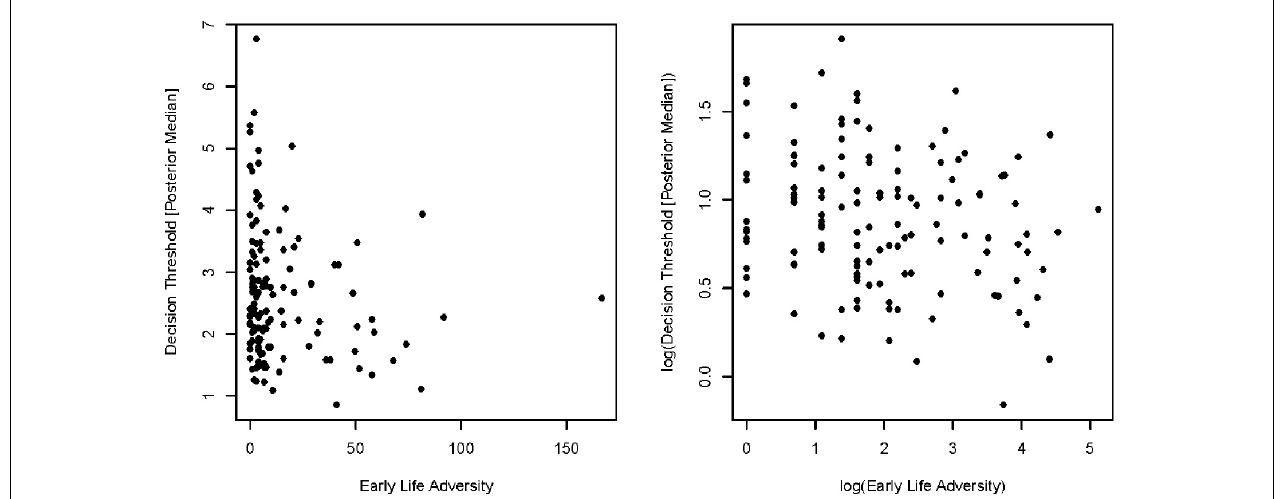
FIGURE 1 | Scatterplot showing the relationship between our measure of early life adversity ( x -axis) and posterior median estimate of decision threshold ( y -axis), using the pre-transformed values (left) and log-transformed values (right). Although there appears to be some relationship between these two variables, the relationship appears to show some level of non-linearity, where participants with low levels of early life adversity often having extremely high thresholds, but this being less true of participants with greater levels of early life adversity. The natural logarithm transformation appears to remedy this issue, making the relationship fairly linear.